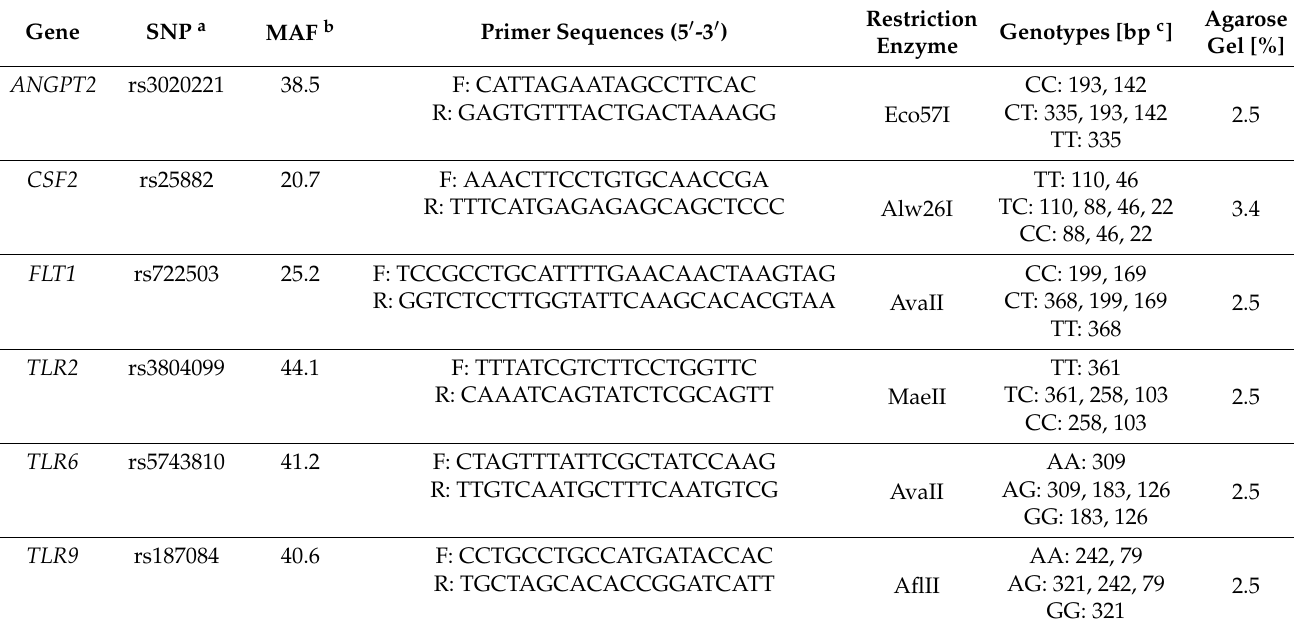
Table 2. PCR-RFLP assays, used in the genotyping of six SNPs, located in the ANGPT2 , CSF2 , FLT1 , TLR2 , TLR6 and TLR9 genes